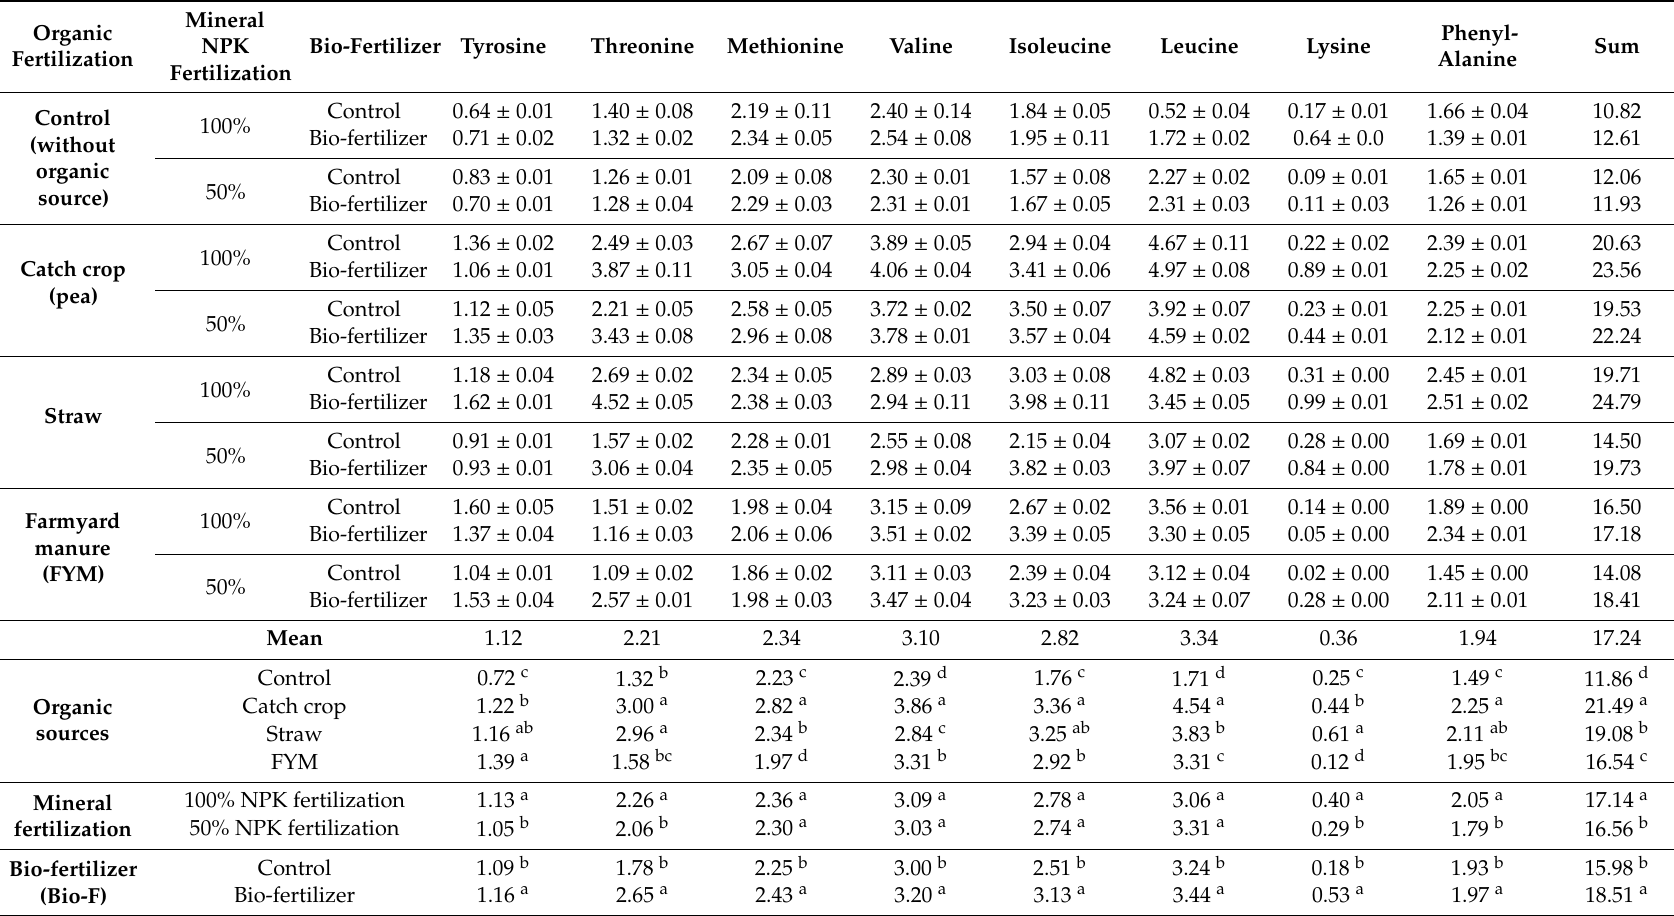
Table 7. Essential amino acids content (g 100 g − 1 protein) in potato tubers. Mean for three years of